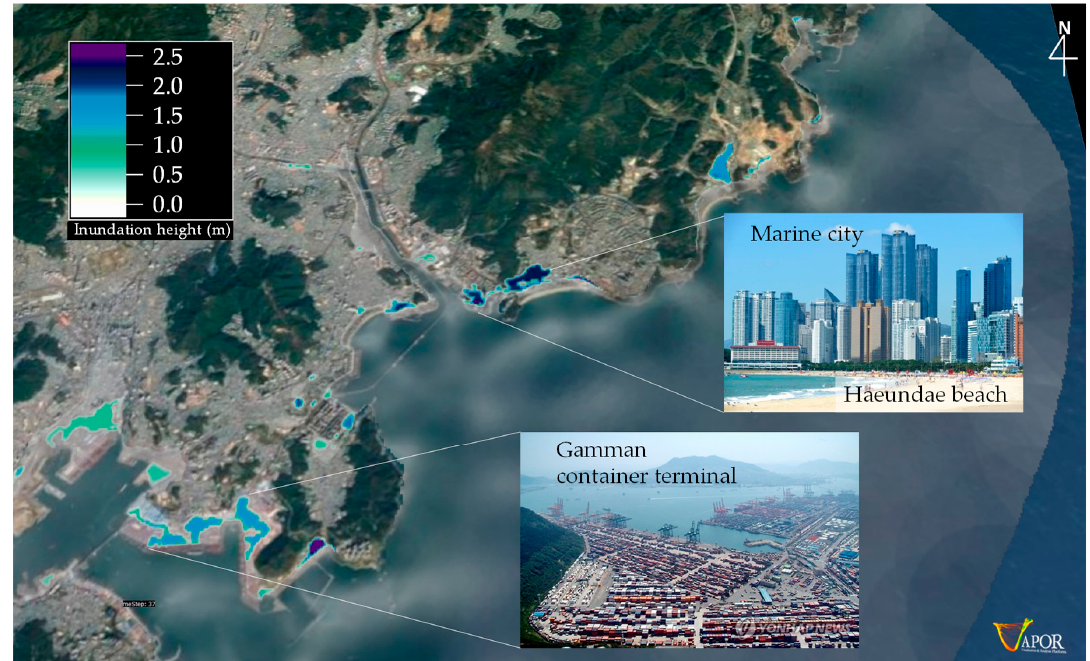
Figure 12. Visualization of coastal inundation results on the South coast near Busan city. with